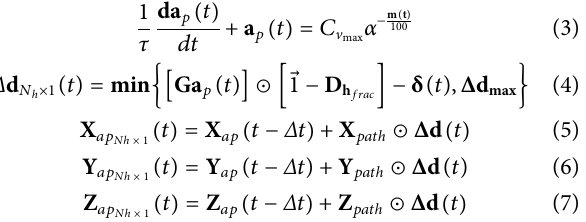
Frontiers in Energy Research |